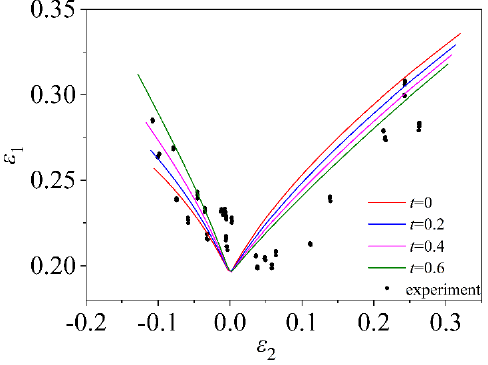
Figure 25. FLD of material AA5182 based on modified VOCE constitutive equation and MMFC in-